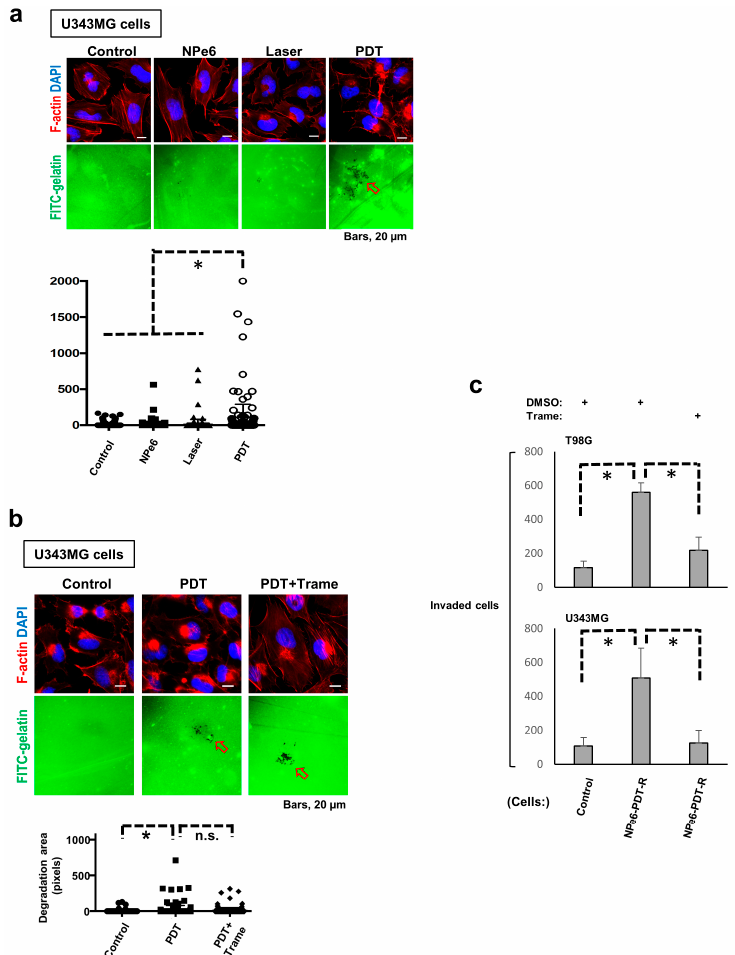
Figure 5. Invasion of NPe6-PDT-R cells is augmented in an ERK1/2 activation-dependent manner, but extracellular matrix degradation in NPe6-PDT-R cells is upregulated independent of ERK1/2 activation. ( a ) U343MG cells were subjected to vehicle treatment, NPe6 treatment (15 μ g·mL − 1 ), laser treatment, or NPe6-PDT (NPe6, 15 μ g·mL − 1 ) as shown in the figure. After 3 days, these cells were subjected to the invadopodia assay as described in the Materials and Methods. Representative fluorescence images of confocal microscopy (upper) [red fluorescence, phalloidin (actin); blue fluorescence, DAPI (nucleus); green fluorescence, FITC-gelatin] and invadopodia formation (lower, * p < 0.01) were examined. Arrowhead denotes degradation sites on the gelatin matrix. ( b ) U343MG cells were subjected to vehicle treatment (control) and/or NPe6-PDT (NPe6, 15 μ g·mL − 1 ). After 3 days, the cells were subjected to invadopodia assay with or without trametinib pretreatment (10 μ M) for 12 h, and the results are shown in Figure 5A. Arrowheads denote degradation sites on the gelatin matrix. * p < 0.01. ( c ) T98G and U343MG cells were subjected to vehicle treatment (control) or NPe6-PDT